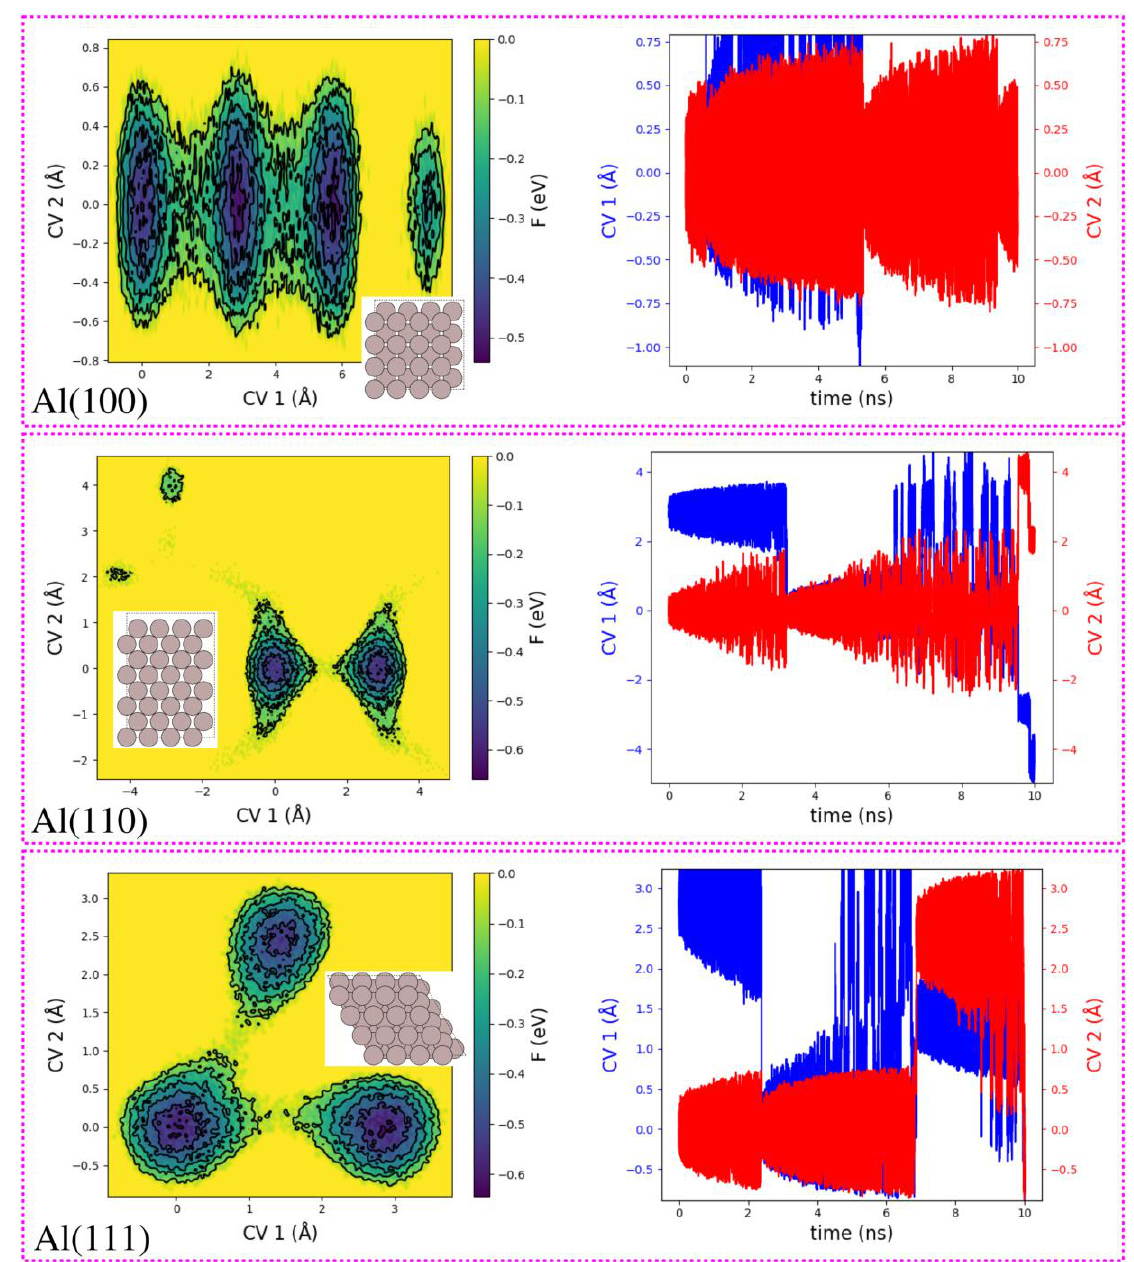
Figure 3. Plots showing the free energy surfaces as a function of the chosen CVs ( left panel) and evolution of the CVs over the simulation time in nanoseconds ( right panel) of the reconstructed Al(100), Al(110), and Al(111) slabs having a surface atomic vacancy. All energy values are in eV and all distance values are in